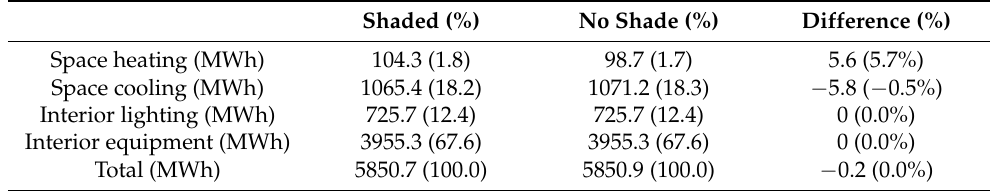
Table 4. Influences of shades on building energy demand of building # 8 of scenario 0. Parentheses for “shaded” and “no shade” are ratios to the total. Parentheses for “difference” are ratios with “no shade”. “Difference” is calculated as “Shaded”–“No shade”. Shaded